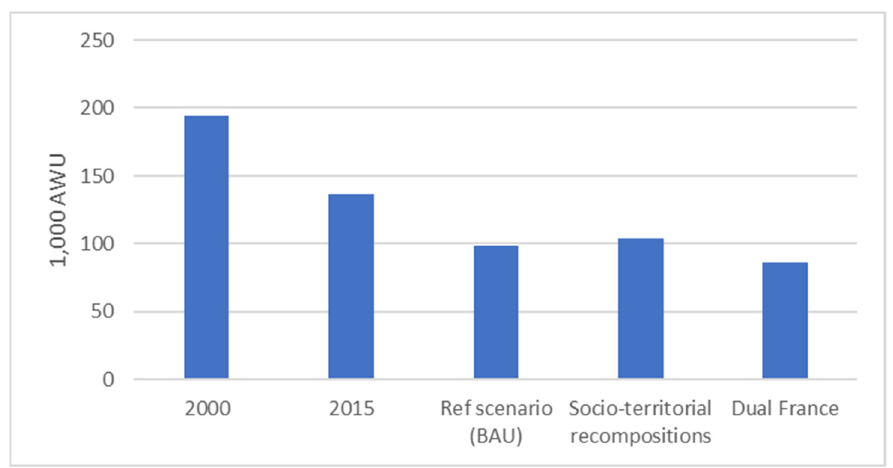
Figure 6. Annual Work Unit (AWU) in dairy farms in 2000, 2015 and in 2030 scenarios (Source: RICA, SP_Calc).